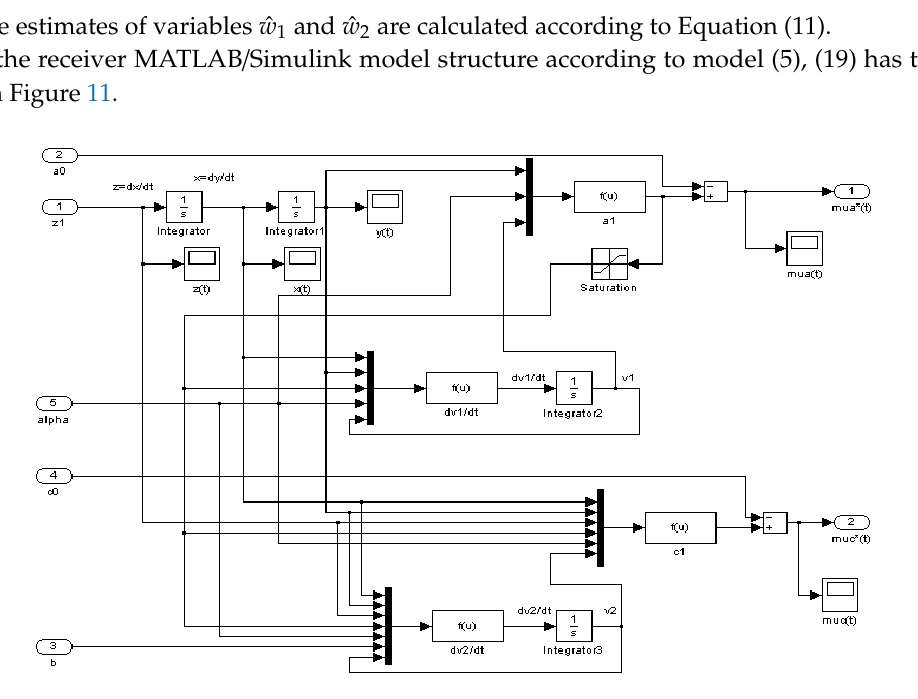
Figure 11. MATLAB / Simulink model of the receiver (two-channel Figure 11. MATLAB/Simulink model of the receiver (two-channel observer).